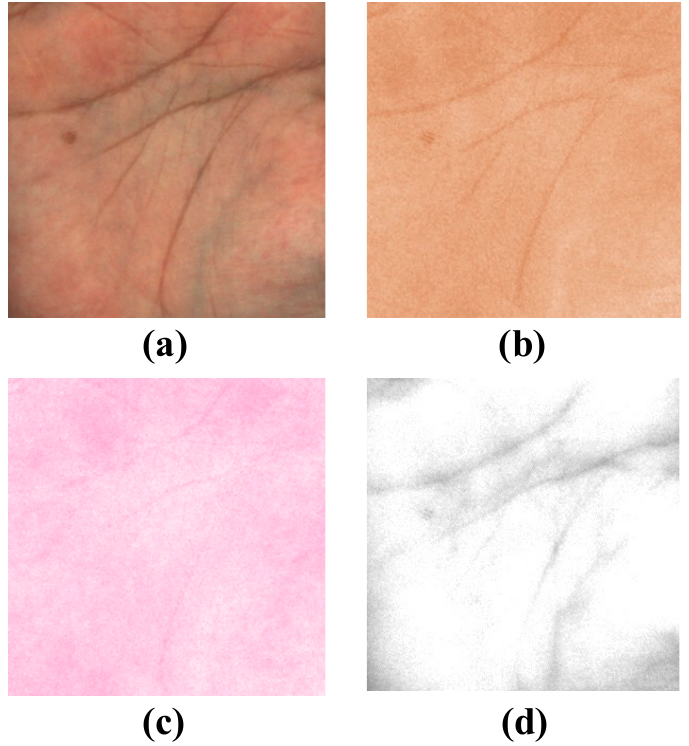
Figure 1. Results of pigment component separation for a skin image: ( a ) original image; ( b ) melanin component; ( c ) hemoglobin component; ( d ) shading.